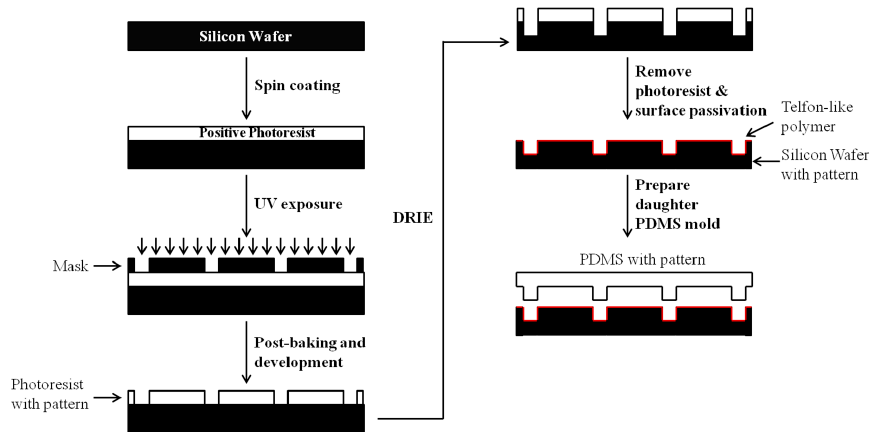
Figure 2. Schematic illustration on the fabrication process of a micropatterned polydimethylsiloxane (PDMS) scaffold by combining lithography and deep reactive ion etching